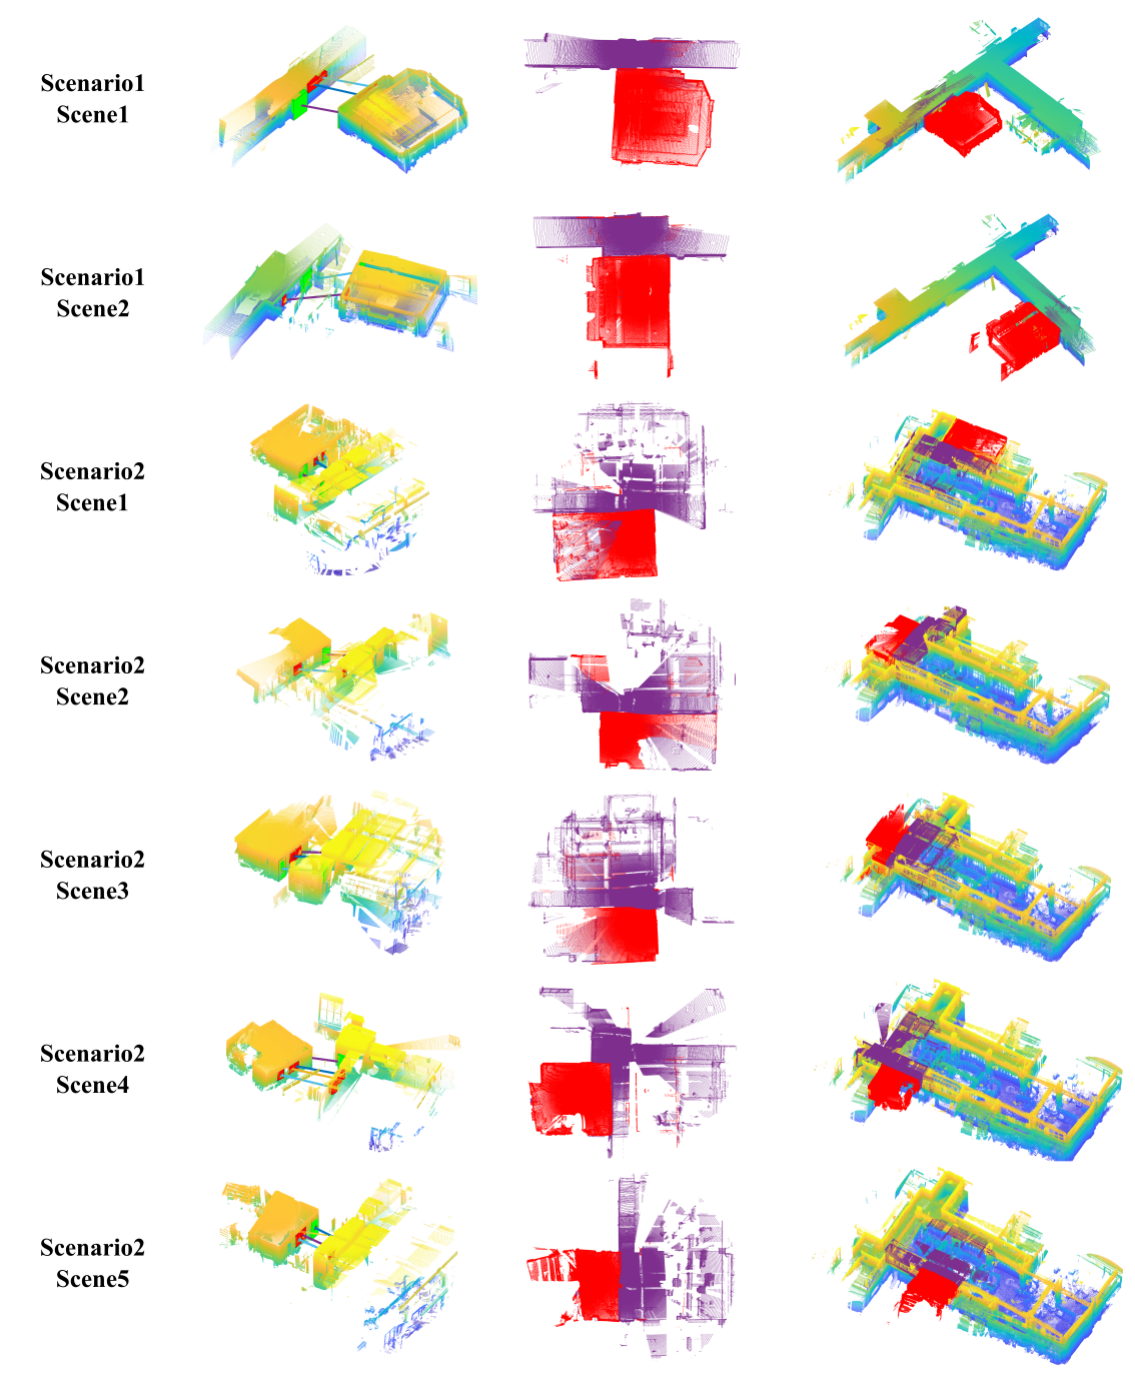
Figure 11. The alignment effect using semantic object matching results. The first column illustrates the found correspondences between indoor and outdoor models. The second column depicts the point cloud after alignment on the top view, where the indoor models are colored in red, and the outdoor models are colored in purple. The third column shows the position of single-scene alignments with respect to the full outdoor